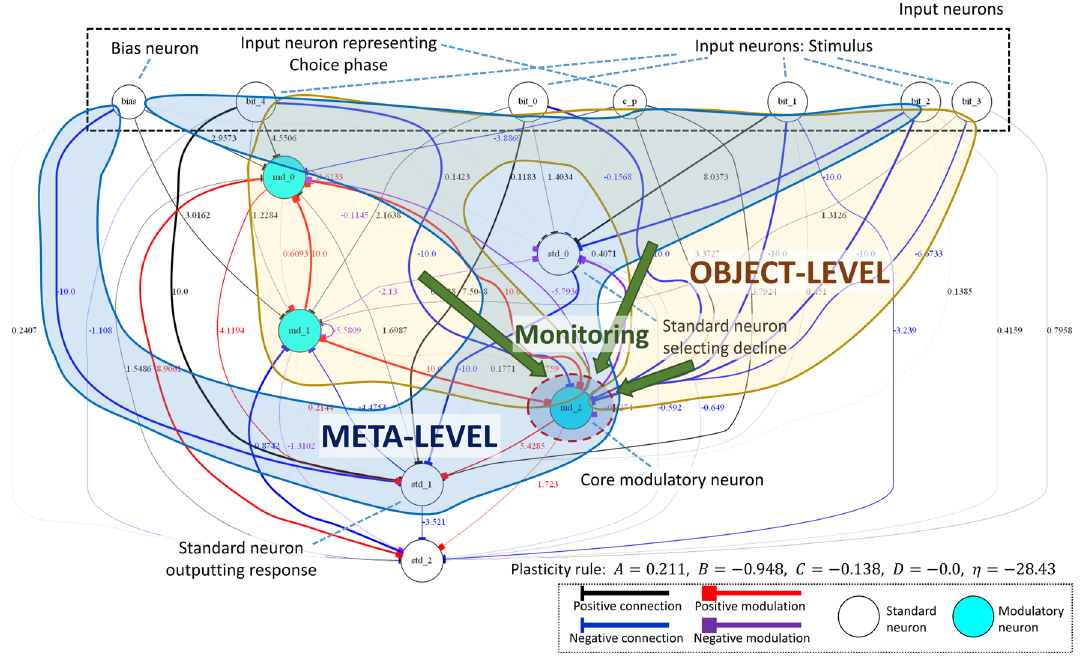
Figure 12. Internal structure of the evolved neural network and its correspondence to the structure of Nelson and Narens’s formulation.